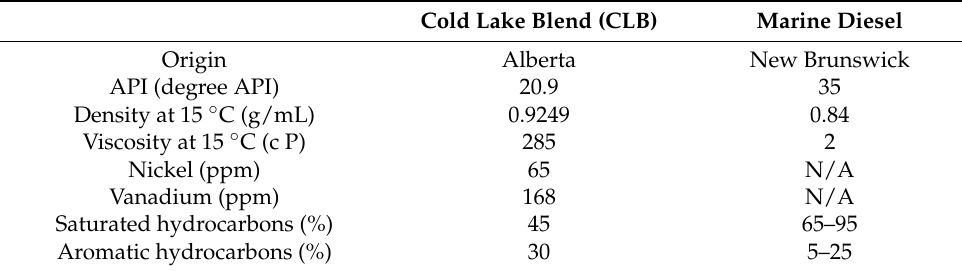
Table 1. Properties of Cold Lake Blend and marine diesel used in the assays. Data from [50]. Cold Lake Blend (CLB) Marine